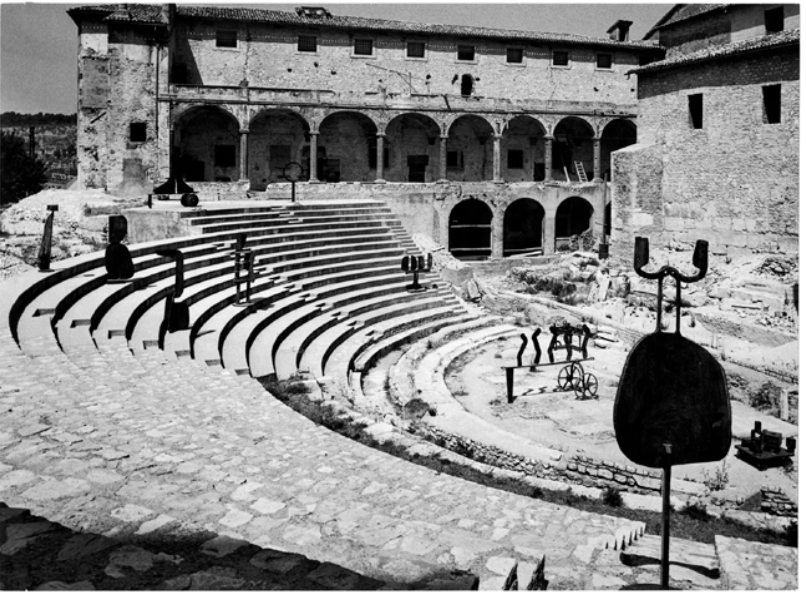
Figure 5. Spoleto, roman amphitheatre, Sculture nella Città ,